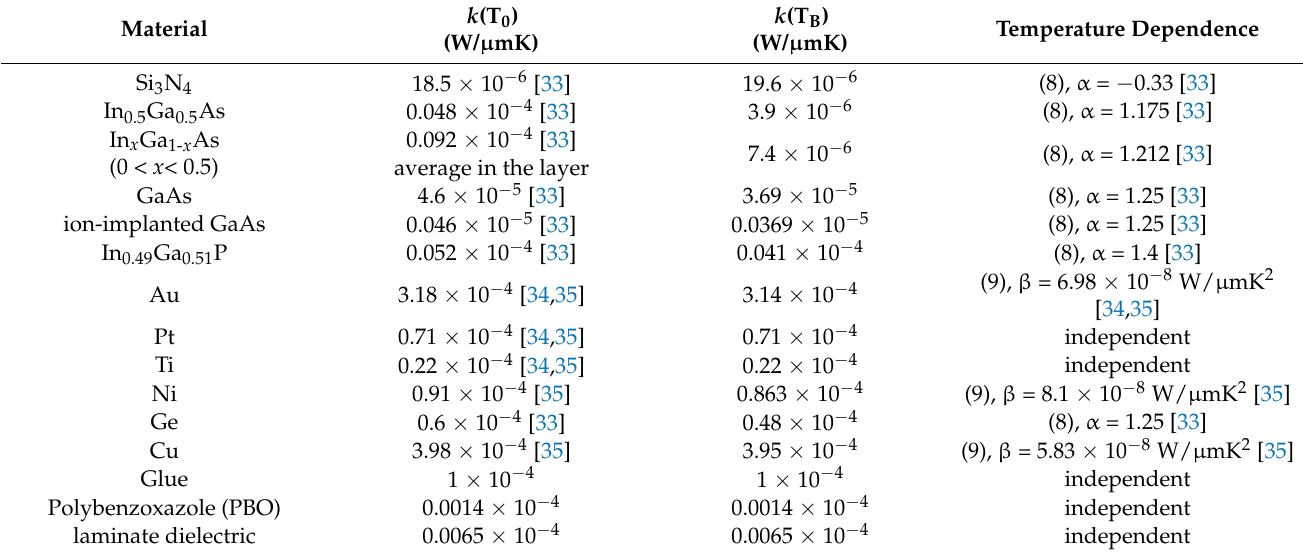
Table 3. Thermal conductivities of the materials composing the devices and